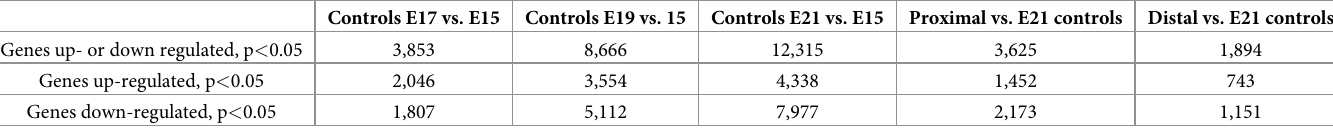
Distal vs. E21 controls